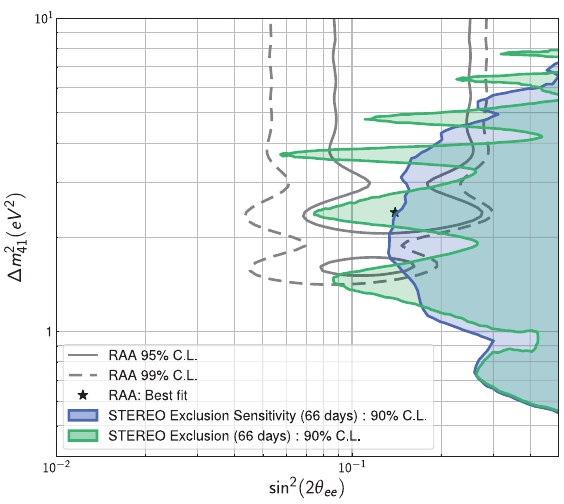
Figure 8. Exclusion contour plot of the oscillation parameter space (from